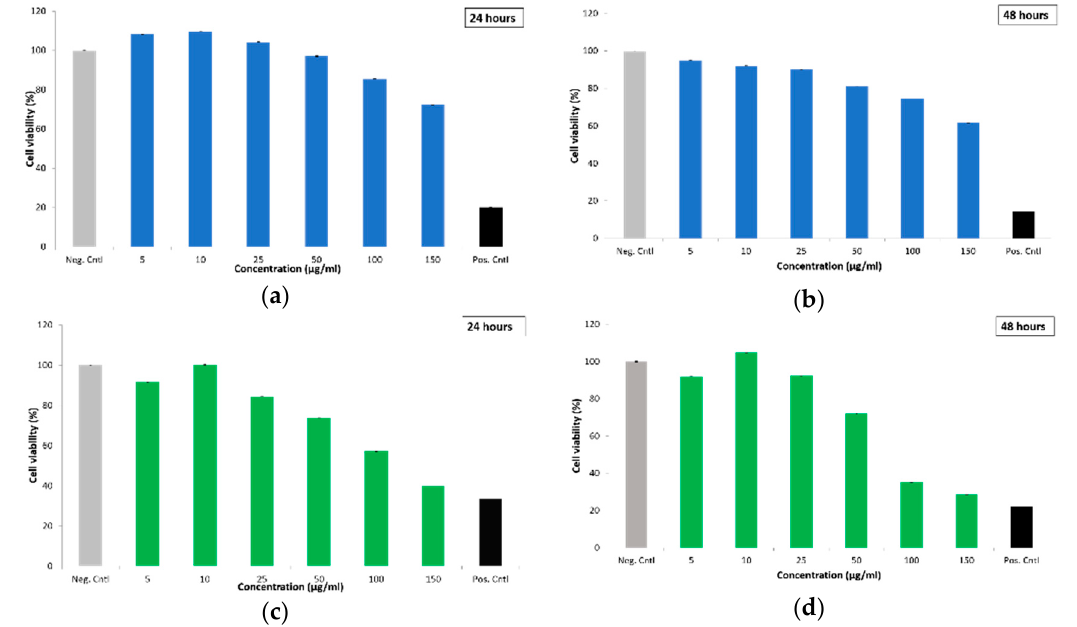
Figure 4. Cell viability of MDA-MB-231 cells as represented using WST-1 assay against the cytotoxic e ff ect of empty MSN@PDA particles, i.e., S-MSN@PDA ( a , b ) and R-MSN@PDA ( c , d ) at 24 and 48 h of incubation, respectively. Negative control indicates untreated cells, while positive control indicates cells treated with 0.1% Triton X-100. The measurements were performed on a plate reader.